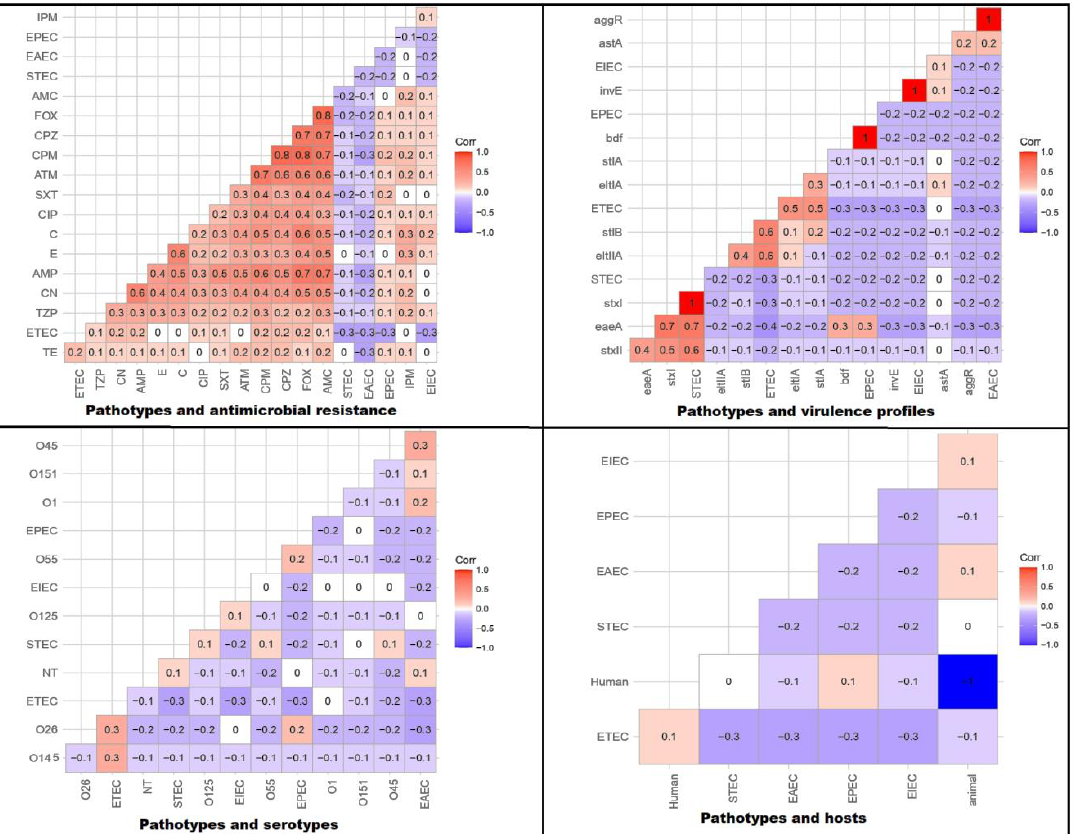
Figure 3. Correlation coefficient ( r ) between diarrheagenic E. coli pathotypes and antimicrobial resistance, virulence gene existence, serotypes, and host types. Red and blue colors specify positive and negative correlations, respectively. The color key denotes the correlation coefficient ( R ). The darker red and blue colors indicate stronger positive (R = 0.5:1) and negative (R = −0 .5:-1) correlations, respectively. TZP: piperacillin/tazobactam, TE: tetracycline, AMP: ampicillin, IPM: imipenem,